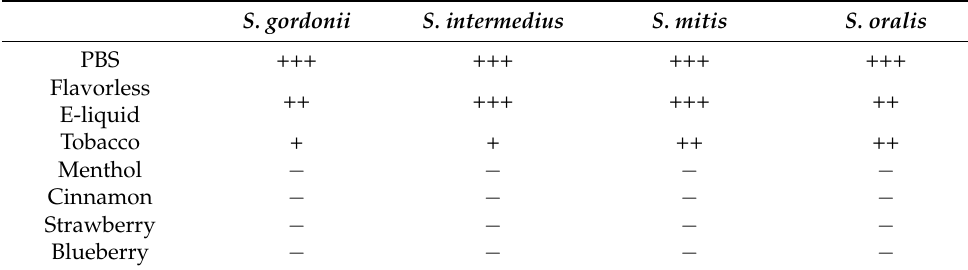
Figure 4. Streptococcal Morphology after E-liquid or stock flavor treatments. Light microscopy images were taken at 1000 × magnification after treatment with 100 µ L of PBS, flavorless E-liquid, or the five stock flavoring agents. The green arrow indicates menthol crystalline formation and the orange arrow points at the presence of a hydrophobic material associated with cinnamon. Black bars on top four images = 10 µ m. Images are representative of four different fields of view. Table 3. Colony Forming Unit